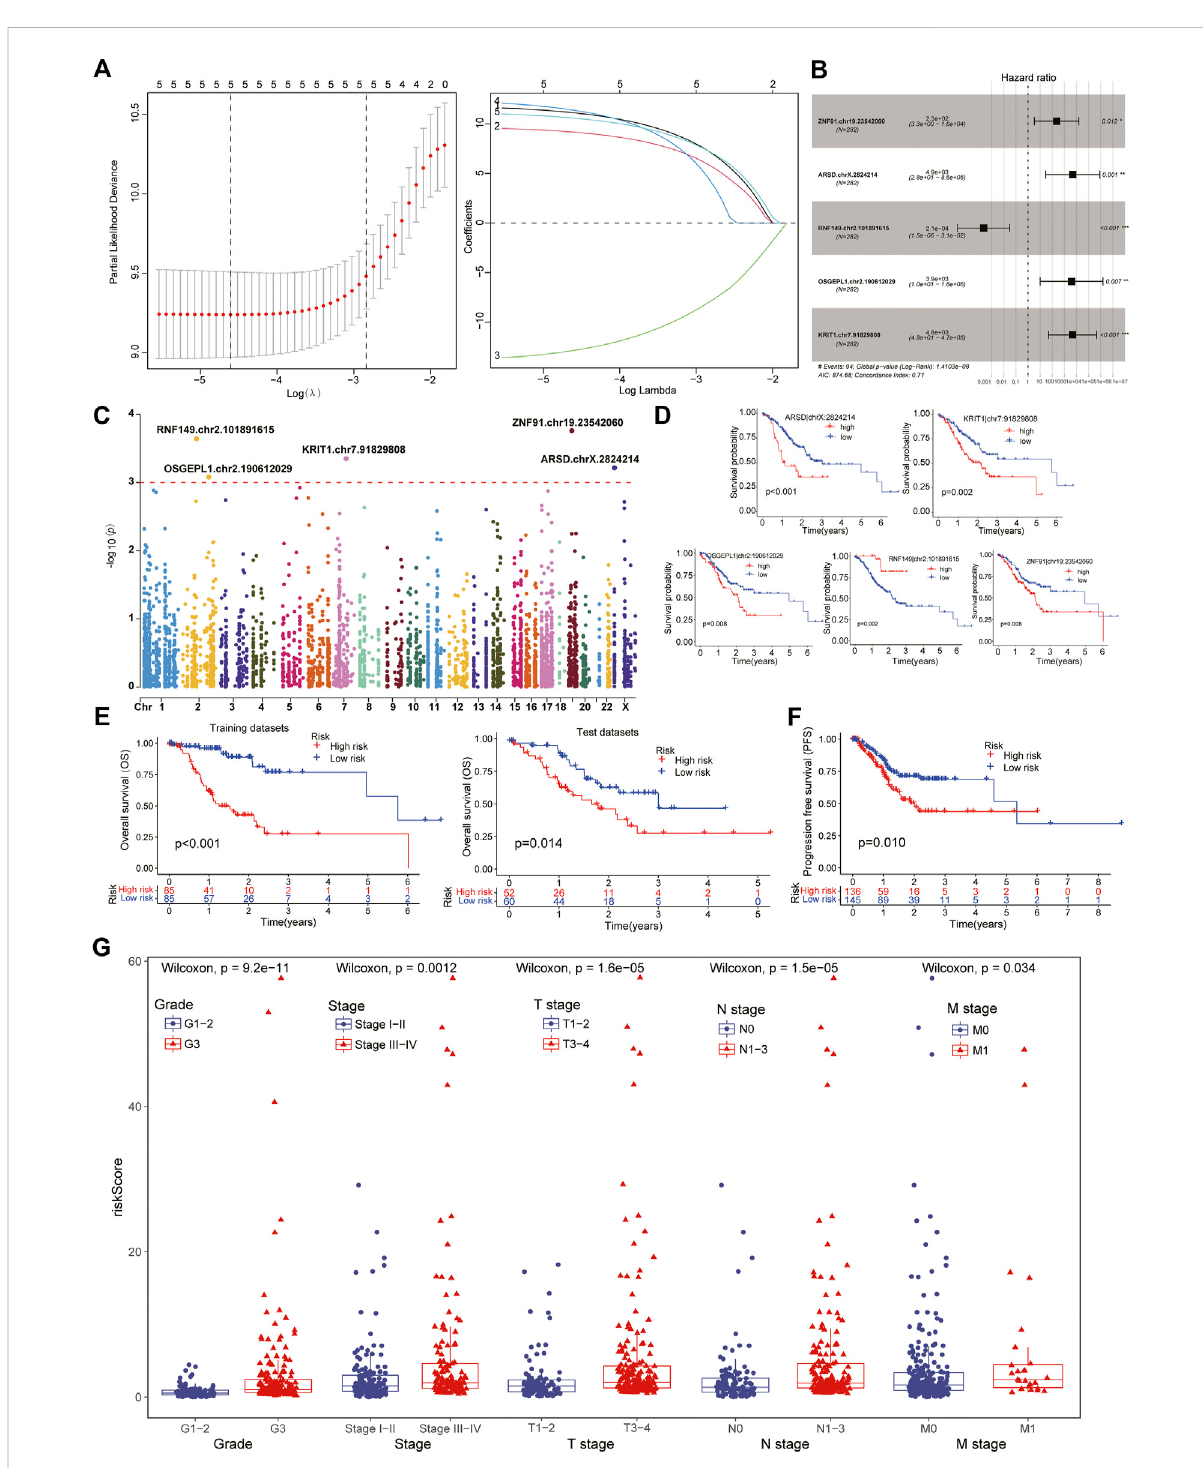
FIGURE 3 Identi fi cation of survival-related ATIRE sites in STAD patients. (A) After the univariate Cox analysis, the LASSO regression obtained fi ve hub sites with the lowest Lambda value. (B) Five vital survival-related ATIRE sites were identi fi ed by multivariate Cox regression analysis, including ZNF91.chr19.23542060, ARSD.chrX.2824214, RNF149.chr2.101891615, OSGEPL1.chr2.190612029 and KRIT1.chr7.91829808. (C) . The Manhattan diagramshowingthechromosomallocationsofabove fi vevitalsites. (D) Survivalanalysisindicatedthatfoursitesweremalgenicsiteswhileone site was protective sites for the prognosis of STAD. (E) Subtypes with low-risk scores exhibited better overall survival than high-risk patients in both training and test datasets. (F) Progression free survival (PFS) analysis also demonstrated a better prognosis in low-risk patients. (G) Clinical comparison showingthat higher ATIRE-Risk scores wereidenti fi edin more severe clinical status including Stage III-IV, Grade III,T3-4,N1-3,and